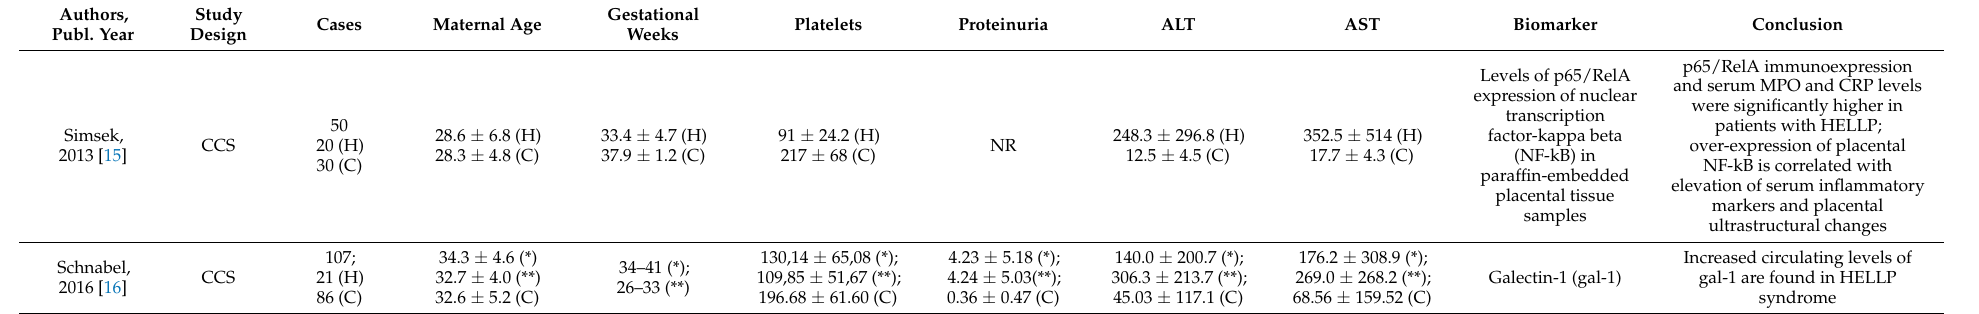
Table 2. Laboratory markers and genetic biomarkers of HELLP. Control = C, Late-onset HELLP *; Early-onset HELLP **; HELLP = H. MPO–myeloperoxidase; CRP–C-reactive protein. Authors, Publ. Year